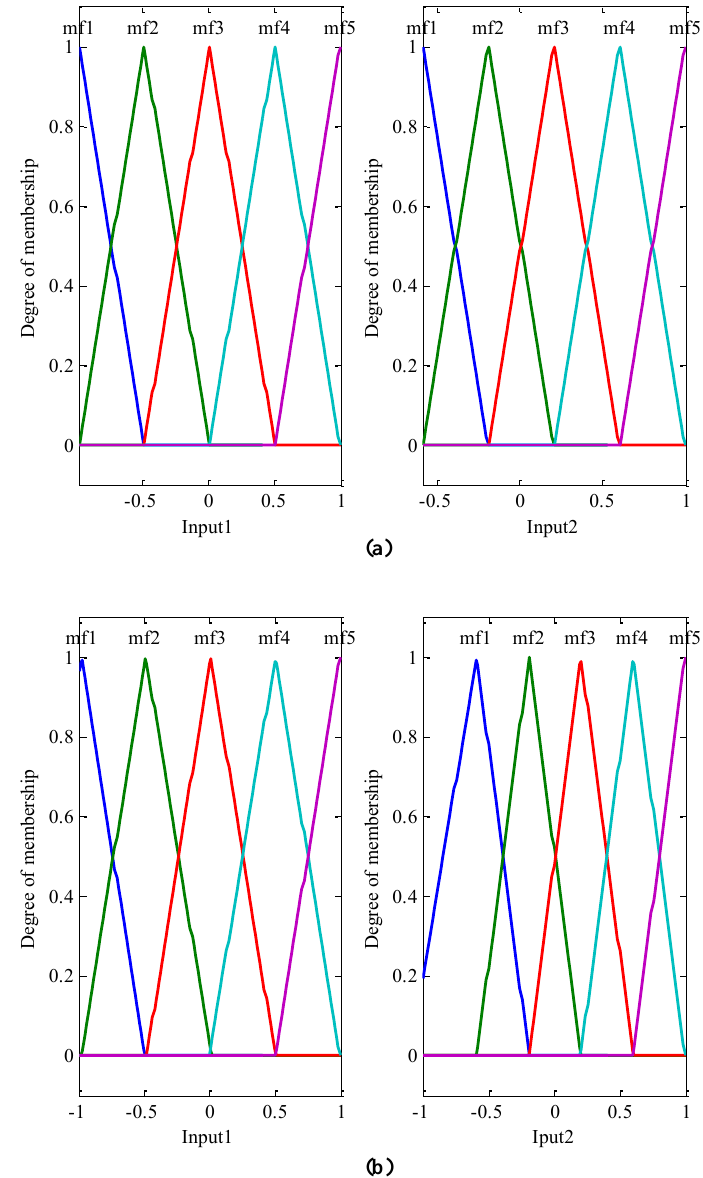
Fig. 6. Triangular membership functions for ANFIS model, (a) initial, (b) algorithm. Figs. 7 and 8 show the comparison between predicted and measured oil flow rate values at training and validation phases for both ANFIS-ICA and ANFIS model, respectively.